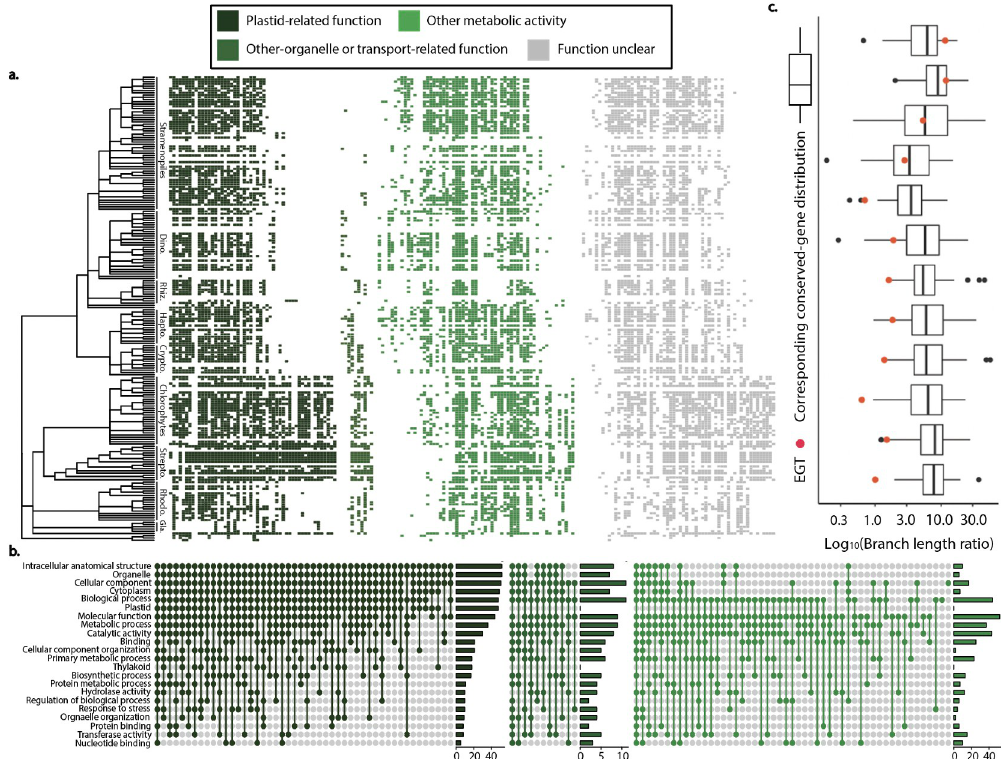
Fig 2. The taxonomic and functional distributions of putative EGTs. (A) The distribution of 189 GFs, categorized by putative function, subject to transfer events (columns) across all photosynthetic eukaryotes included in the study (Dino: Dinoflagellates; Rhiz: Chlorarachniophytes (Rhizaria); Hapto: Haptophytes; Crypto: Cryptophytes; Strepto: Streptophytes; Rhodo: Rhodophytes; Gla: Glaucophytes). (B) Functional categories based on the co-occurrence of Gene Ontology terms designate 52 EGTs as plastid-related (dark green, lefthand panel), 10 as metabolic, catabolic or biosynthetic (medium green, central panel), and 61 as other organellar or transport related (light green, right panel). (C) In comparisons of relative branch lengths, putative EGTs into Archaeplastida (red dots) consistently fall below the relative distance between eukaryotes and prokaryotes in VTG trees (box plots), inconsistent with the alternative hypothesis of gene loss and consistent with the results of similar analyses in other, non-photosynthetic taxonomic groups such as Opisthokonta (Fig 3).